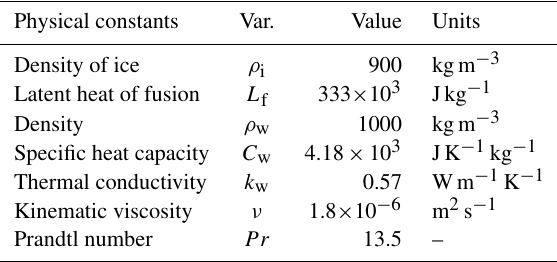
Table 1. Physical constants used in this work. If not specified, con- stant refers to the property of water at 0 ◦